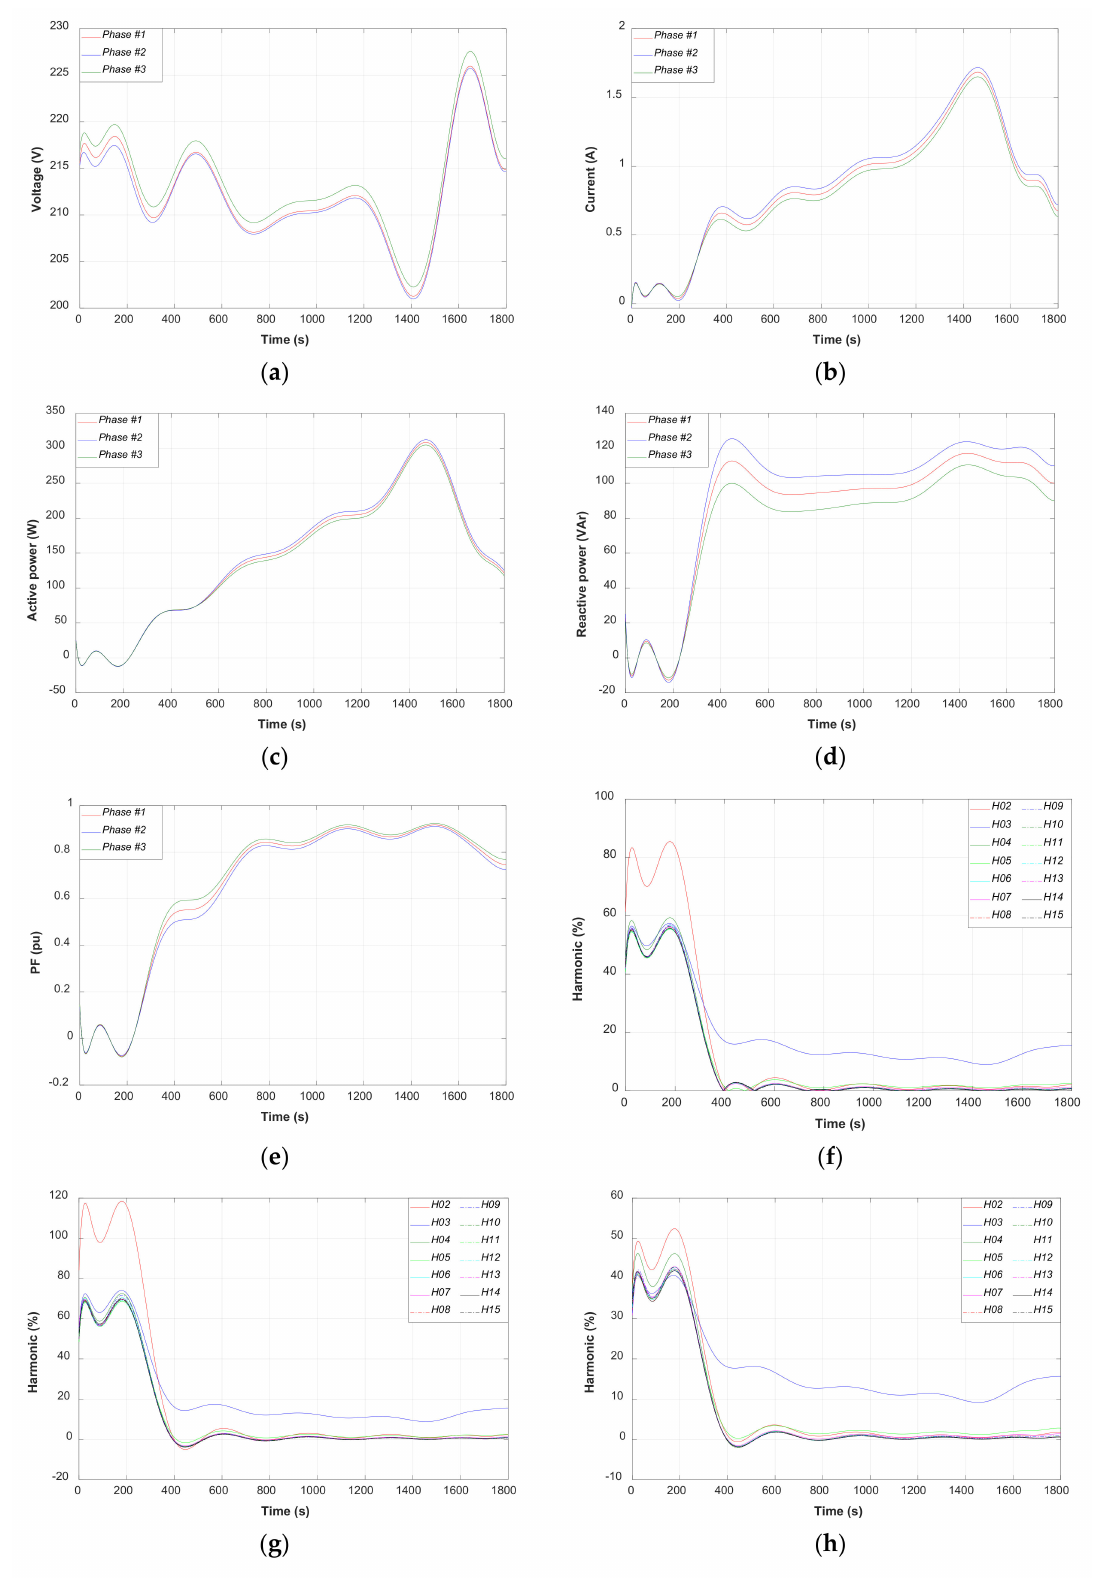
Figure 14. Measured data per phase for a synchronous generator feeding a three-phase asynchronous motor with a squirrel- cage rotor: ( a ) voltages; ( b ) currents; ( c ) active powers; ( d ) reactive powers; ( e ) power factor; ( f ) Phase #1 current harmonics; ( g ) Phase #2 current harmonics; and ( h ) Phase #3 current